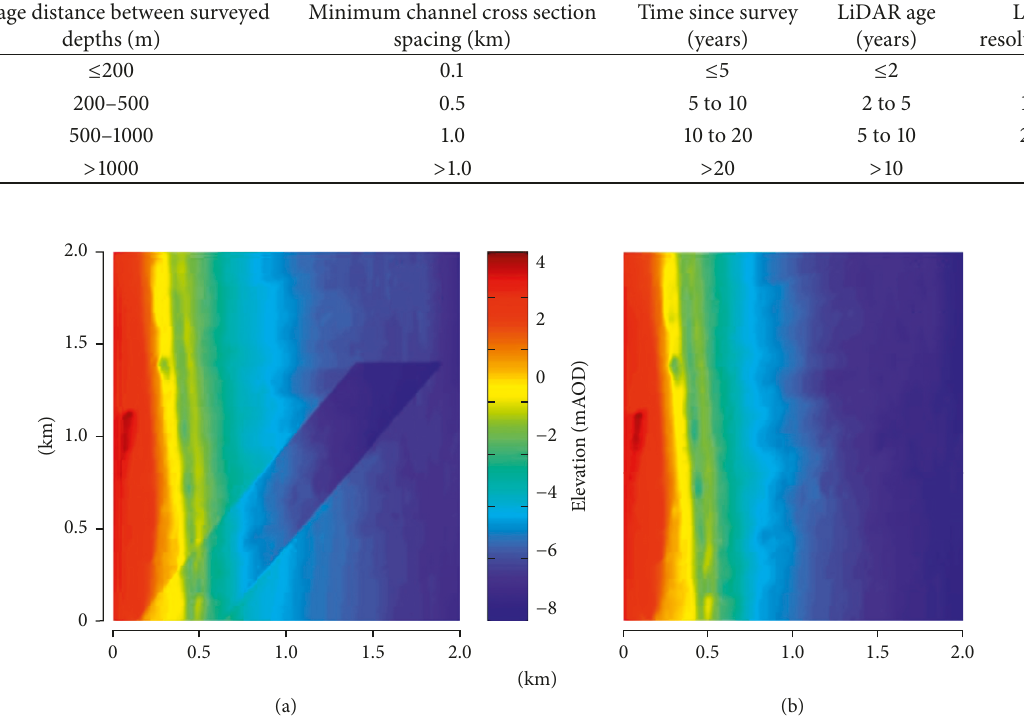
Figure 2: (a) Bathymetry with a clear vertical datum problem and (b) the same bathymetry after datum